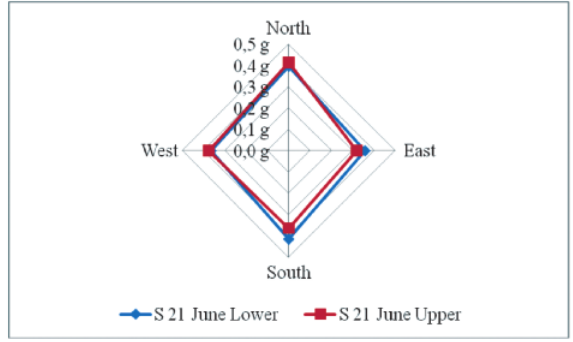
Table 3: The values of the stone mass